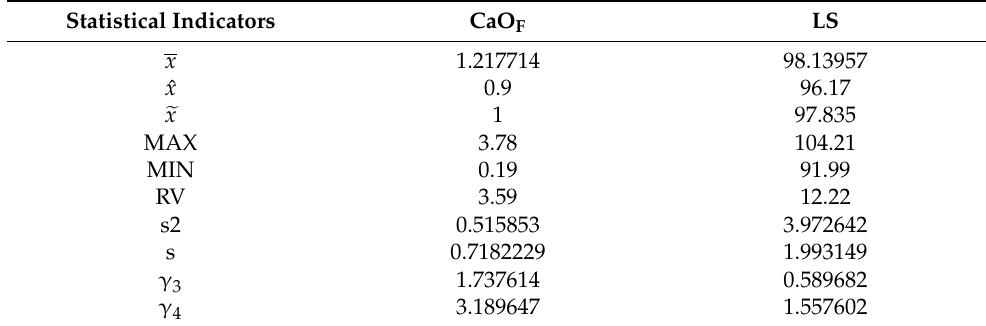
Table 5. Statistical analysis—statistical indicators for CaO F , LS. Source: own source.